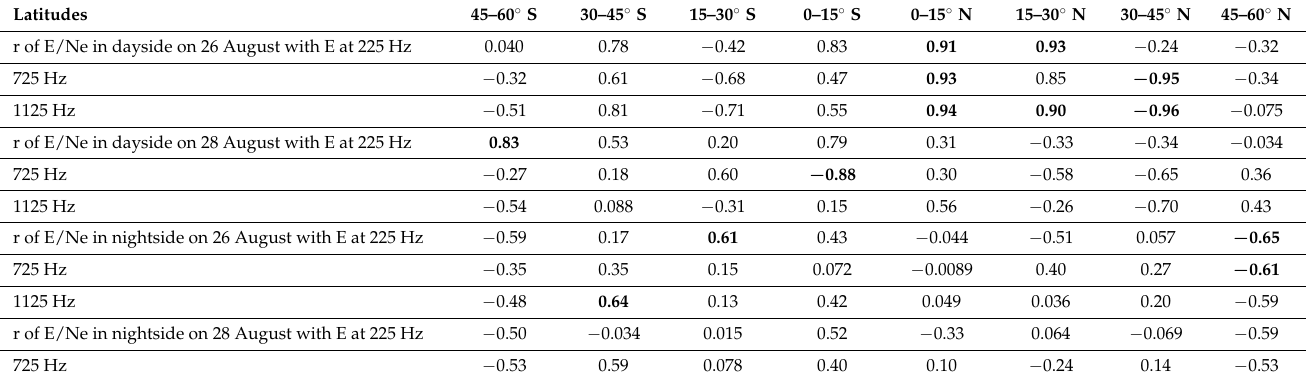
Table 2. The correlation r of E/Ne at different latitudes from CSES on 26 and 28 August. The bold values present the